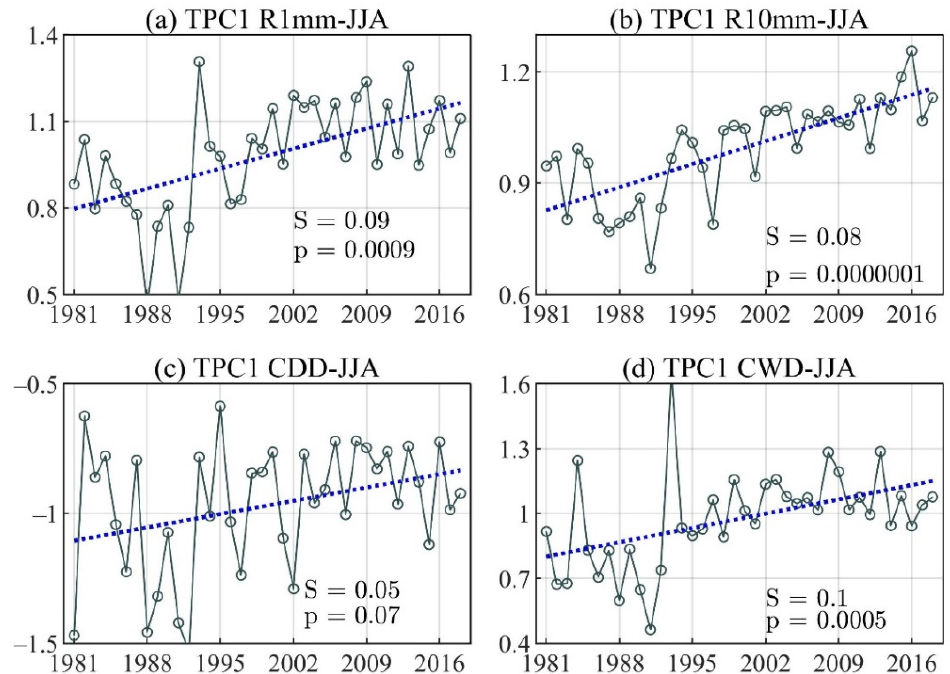
Figure A4. The linear trend of the principal component time series for the first TEOF mode of ( a ) Number of wet days (R1mm), ( b ) Number of days with precipitations above R10mm (R10mm), ( c ) Consecutive dry days (CDD), and ( d ) Consecutive wet days (CWD) during the March–May (MAM) season.